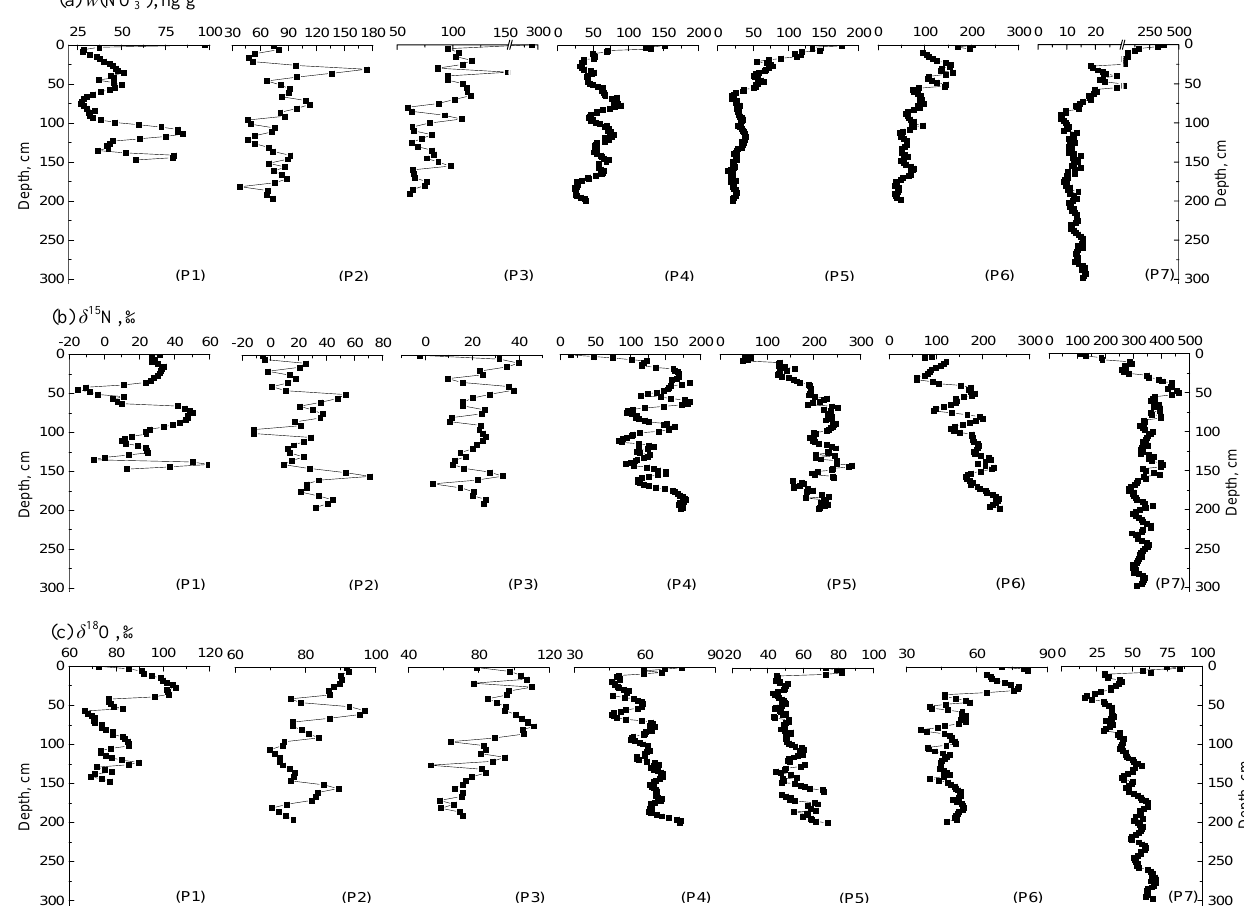
) (a) and isotopic composition δ 15 N (b) and δ 18 O of NO − Figure 3. Detailed profiles of w (NO − 3 ) in P3 and P7 was broken so the trend in the deeper snow can be axis of w (NO − 3